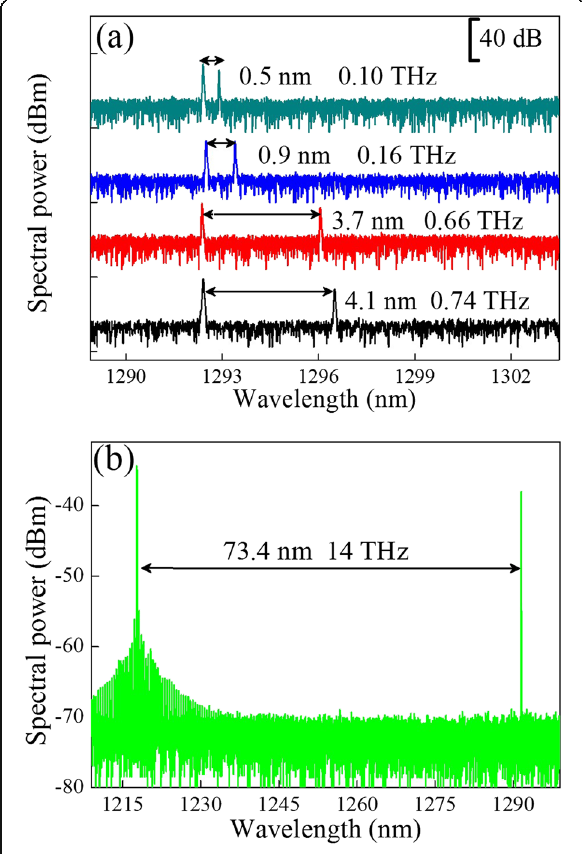
Fig. 4 The spectrum of the dual-mode LC-DFB laser. a Emission spectra of the dual-wavelength LC-DFB laser with a different grating period. b Wide spacing of dual-mode lasing spectra of the LC-DFB laser with an ultra-short cavity length of 450 μ